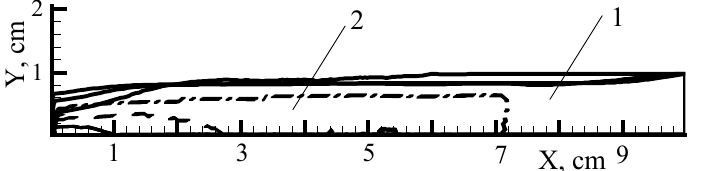
Figure 15: Compacted (1) and destructed (2) regions for three values of the detonation velocity. The solid, dashed, and dot-and-dash lines refer to = 3 D km/s, = 5 D km/s, and = 7 D